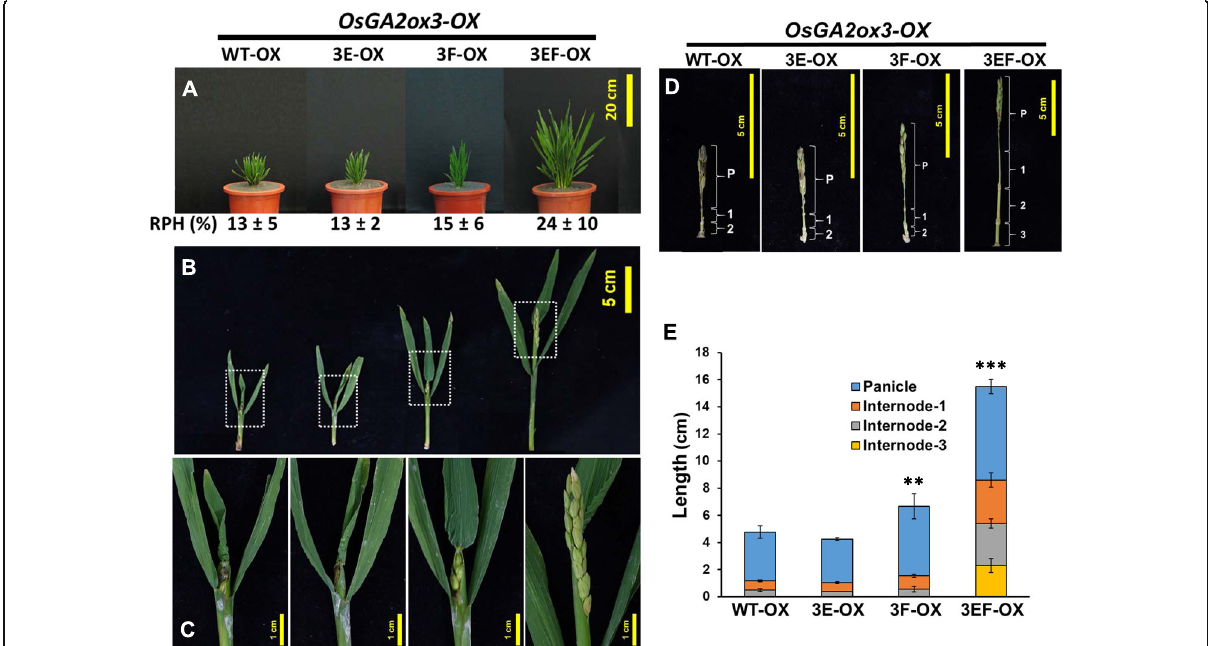
Fig. 7 Phenotypic comparison of WT-OX, 3E-OX, 3F-OX and 3EF-OX transgenic rice plants . a Phenotypic comparison of WT-OX, 3E-OX, 3F-OX and 3EF-OX transgenic rice plants. A representative T 0 transgenic plant with the average RPH resulting from each overexpression line is shown. Values are means ± SE ( n = 5). b A dissected representative main culm from each overexpression plant is shown to compare their emerging panicles at the maturation stage. c Enlarged image from the boxed area of B) to show details. d Comparisons of the length of panicles and internodes from each overexpression line. P: panicle; 1: internode #1; 2: internode #2; 3: internode #3. e Statistical comparisons of the length of the main culms (including panicles and internodes) from each overexpression line. Values are means ± SE ( n = 5). The significant differences using Student ’ s t -test are indicated by * p < 0.05, ** p < 0.01, *** p <